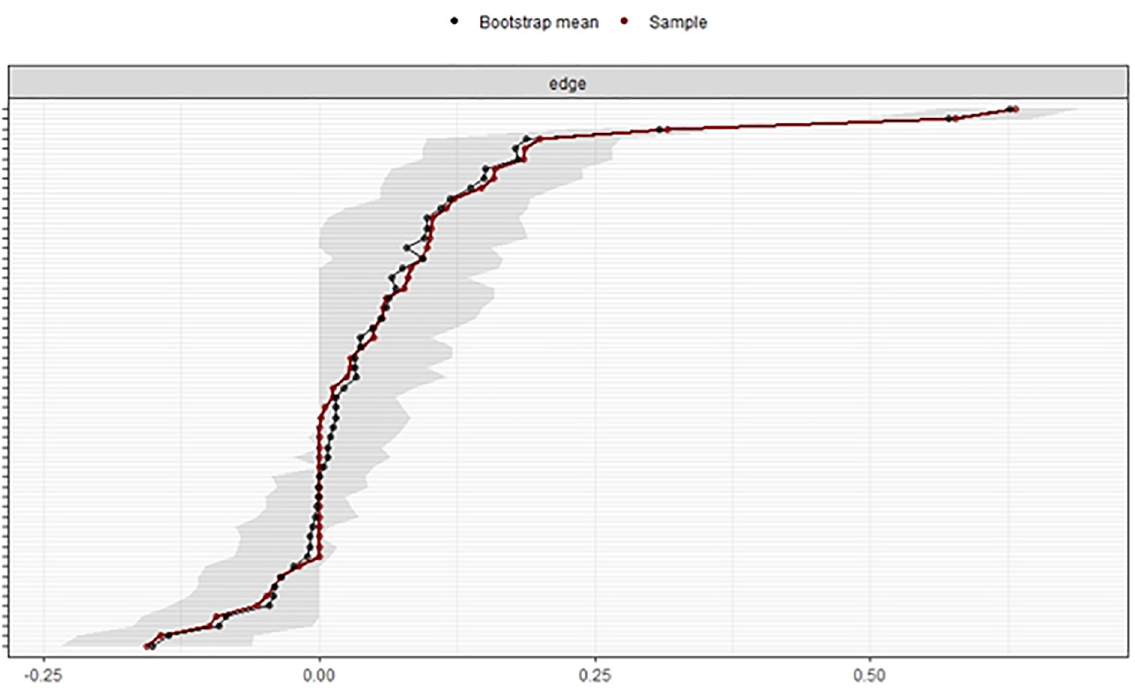
Fig 3. Bootstrapped confidence intervals of estimated edge weights for the estimated network. The red line shows the sample values, and the gray area shows the bootstrapped CIs. Each horizontal line represents one edge of the network. The top is the highest edge weight, and the bottom is the lowest edge weight. Y-axis labels were removed to avoid